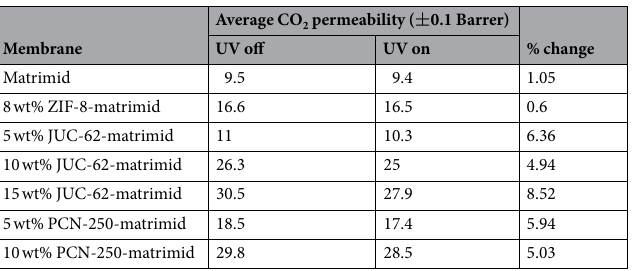
Table 1. CO 2 permeability of light-responsive mixed matrix membranes with and without